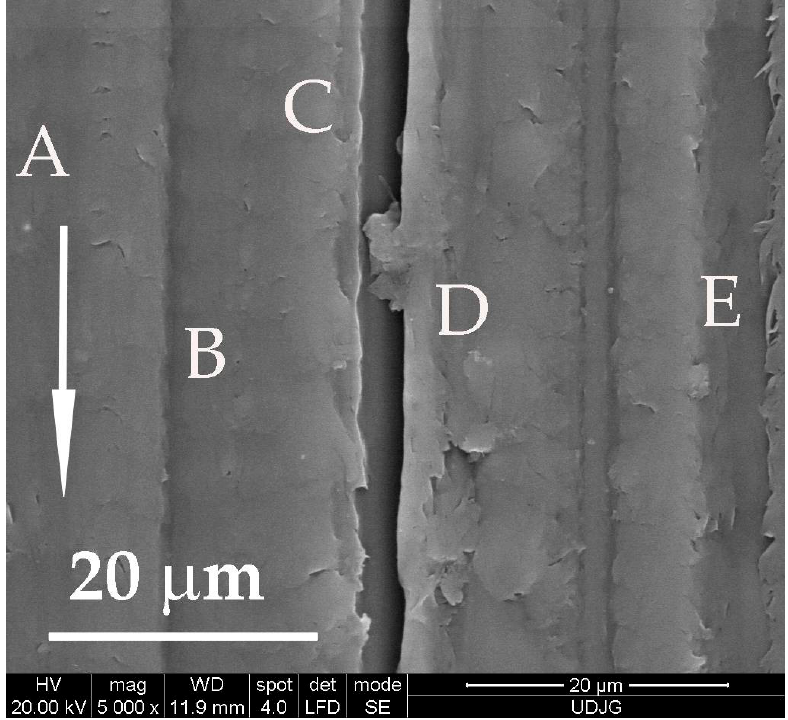
Figure 10. Wear mechanisms, identified on the worn surface of the block made of PBT (F = 5 N, v = 0.25 m/s, L = 5000 m).